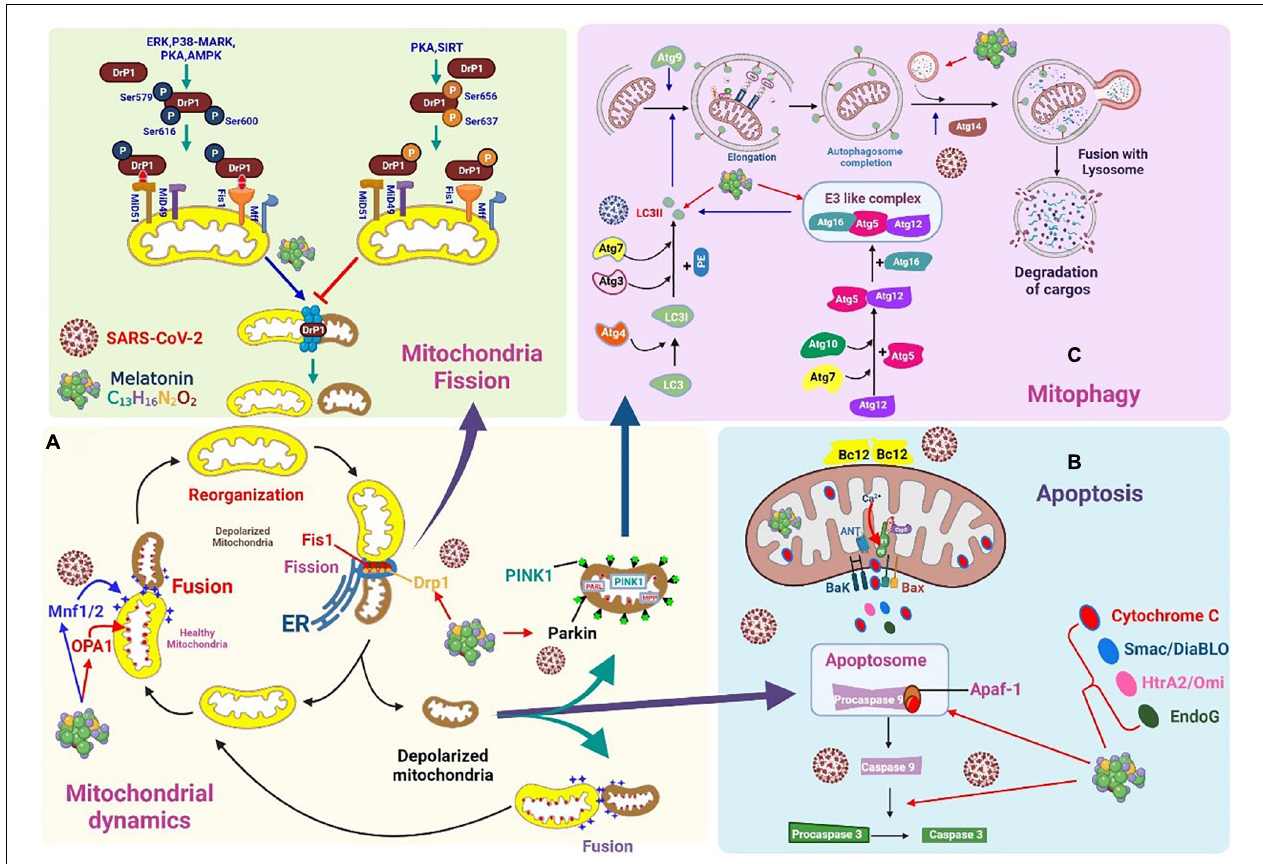
FIGURE 5 | Severe acute respiratory syndrome coronavirus 2 affects mitochondrial dynamics, mitophagy, and apoptosis. (A) Mitochondrial fusion is mediated by mitochondrial dynamin-related guanosine triphosphatases, which include mitochondrial fusion proteins 1 and 2. Melatonin downregulates Drp1 expression and suppresses mitochondrial fission. (B) Viral protein and open reading frame may induce mitochondria apoptosis. Melatonin may modulate processes associated with apoptosis, which reduces viral spread. (C) Coronaviruses can alter mitochondrial dynamics and the status of mitochondrial autophagy to promote interference with the normal antiviral signaling pathway of cells and maintain infection. Melatonin may promote mitophagy via LC3II, autophagosome-lysosome fusion, and E3-like